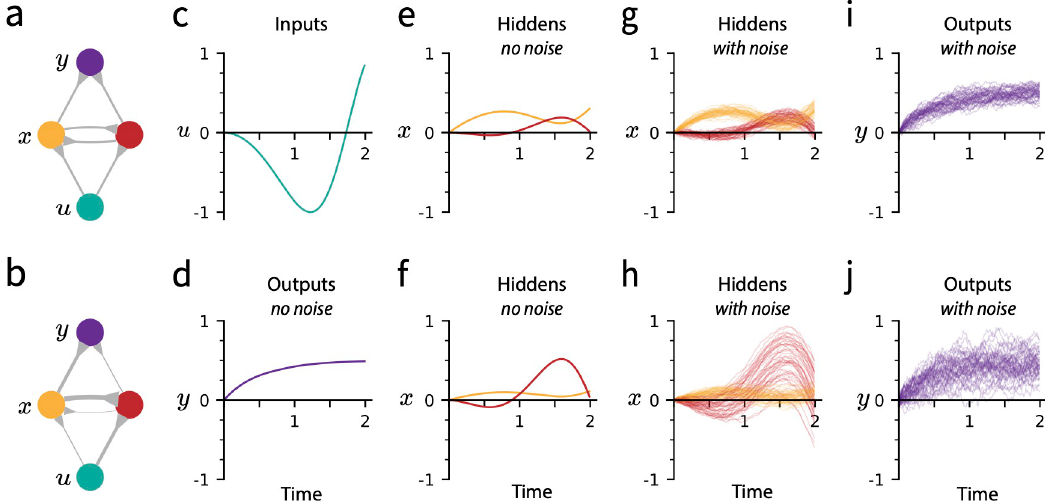
Fig 1. Two nonlinear recurrent networks consisting of input, hidden, and output neurons possess an identical input-output relationship, but behave differently in the presence of noise. (a-b) A single input u (teal) drives two recurrent neurons x 1 (yellow) and x 2 (red) which project to a single output y (purple). The connectivity patterns of the two networks are related by the task- preserving transformation (4). Line thickness denotes synaptic strength. (c) Input trajectory, fed to both networks. Horizontal axis in all panels is time. (d) Output trajectory, produced by both networks when run according to the deterministic dynamics (1). (e-f) Hidden unit neural activity under deterministic dynamics, for networks a and b respectively. Trajectories are identical up to a per- neuron scale factor, determined by the parameters of the task-preserving transformation. (g-h) Hidden neuron neural activity for networks a and b respectively when additive Gaussian noise is injected into the neural dynamics (1). 50 trials are shown. (i-j) Output neuron neural activity in the noisy